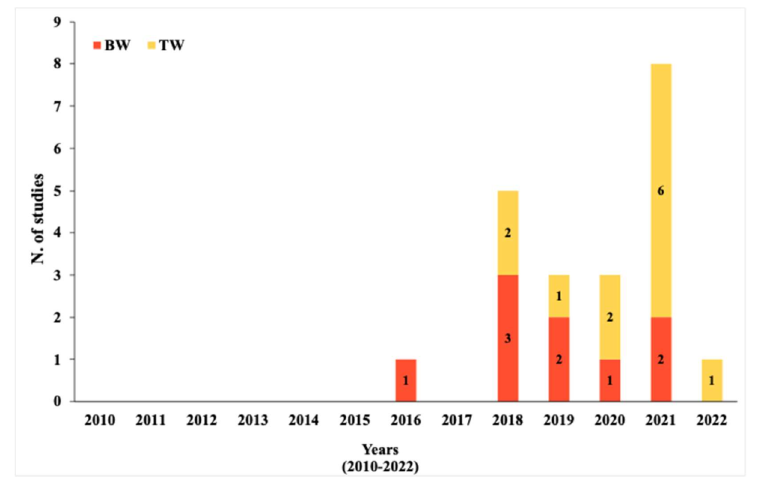
Figure 2. Temporal representation of current studies on DW from 2010 to 2022. Figure 3 represented a geographical representation of data on MPs. MP occurrence